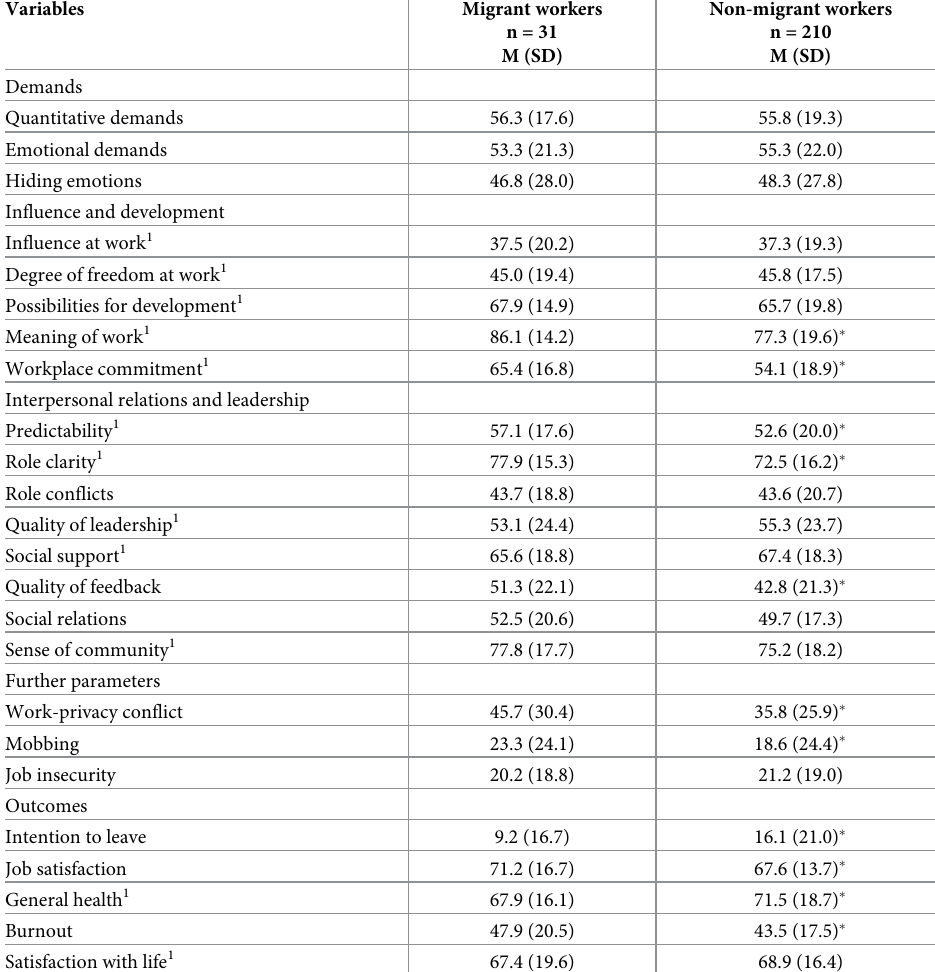
Table 4. COPSOQ scales’ means (standard deviations) and differences between migrant and non-migrant